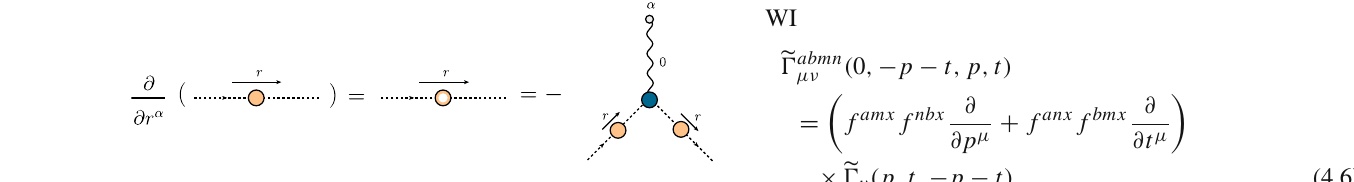
Fig. 7 Diagrammatic representation of the WI for the B ¯ cc vertex, where the derivative of the ghost propagator can be identified as the insertion of a zero-momentum background gluon leg. Here we define the notation of a perforated circle as being the derivative acting on the Green’s function